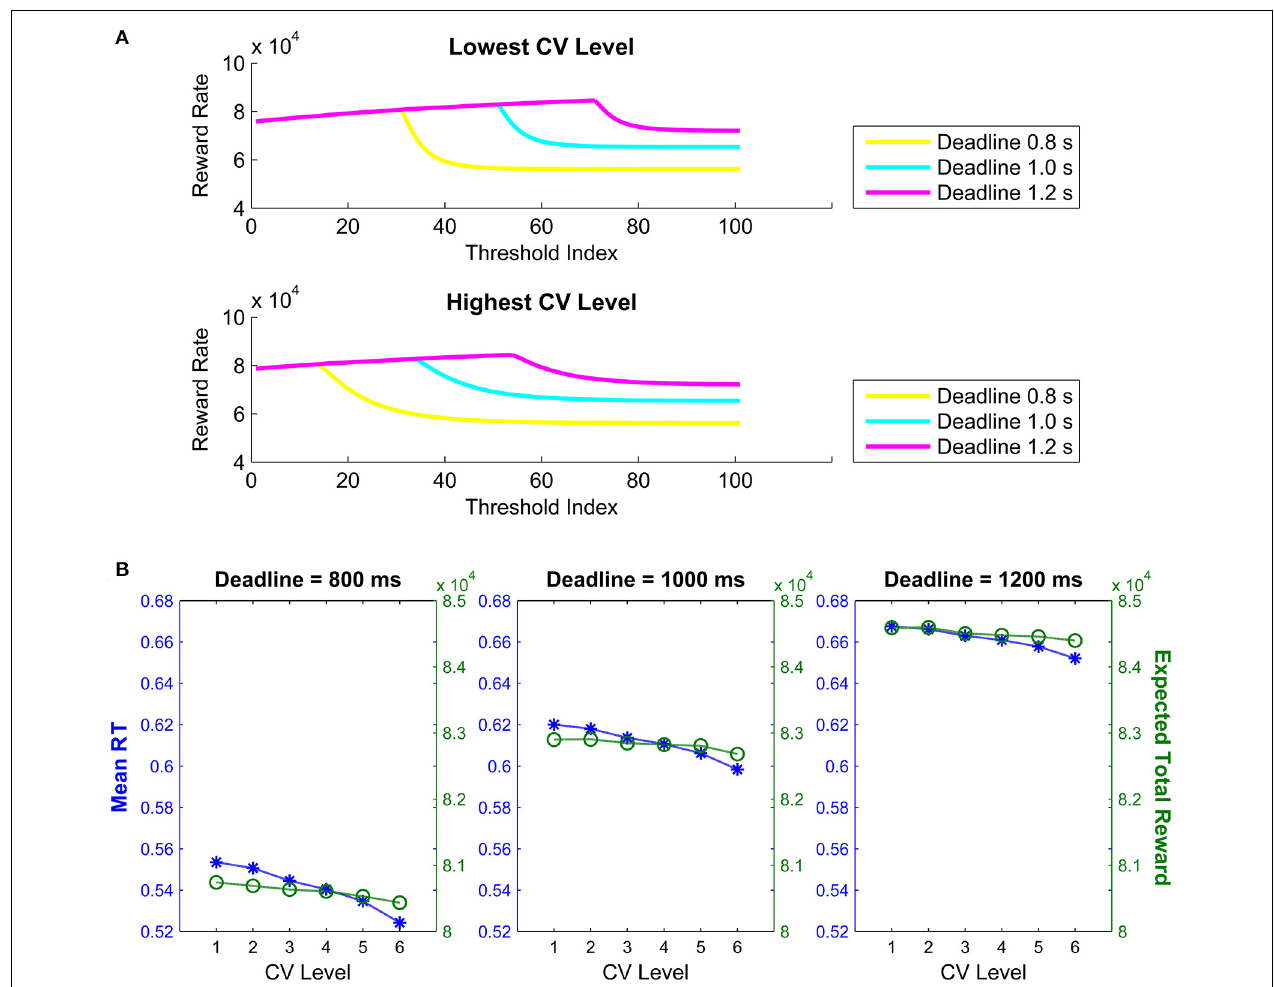
FIGURE 5 | (A) Expected total reward amount for the highest and lowest CV levels as a function of the order of threshold among the 101 thresholds tested (here defined as “Threshold Order”). (B) Mean response times and expected total reward amounts as a function of six